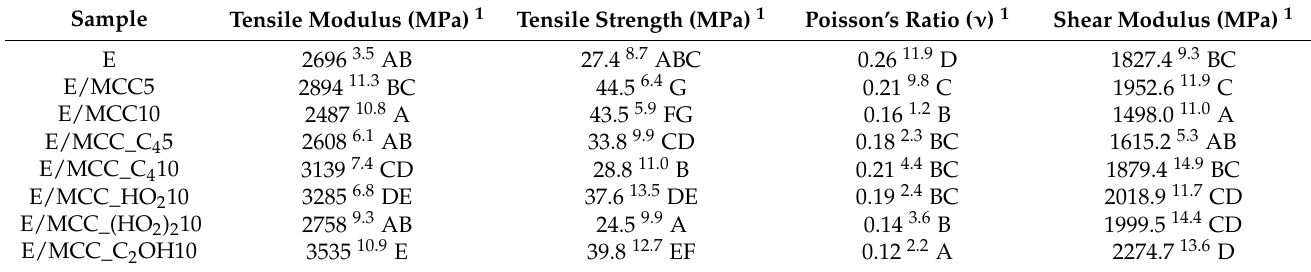
Table 3. Tensile test-derived results for epoxy and the MCC/epoxy